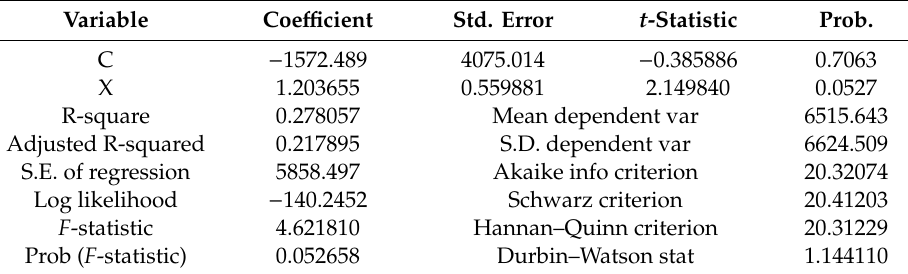
Table 5. Results of Yamazaki bread.